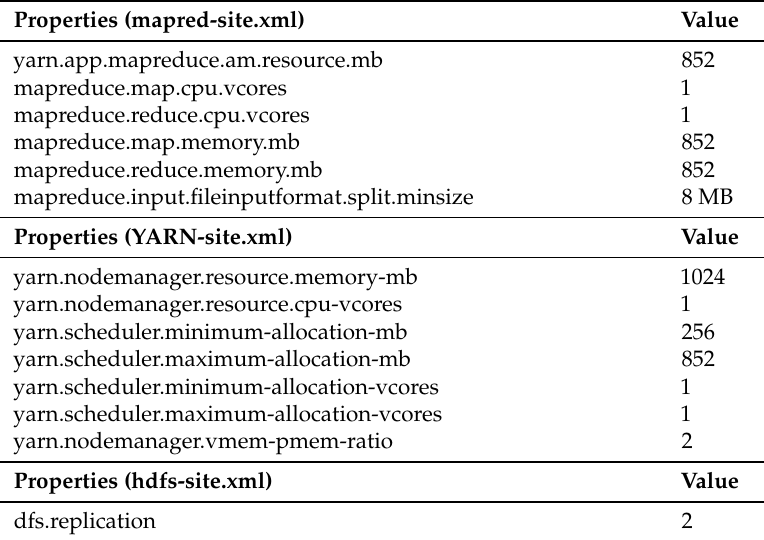
Table 6. Properties in Hadoop configuration